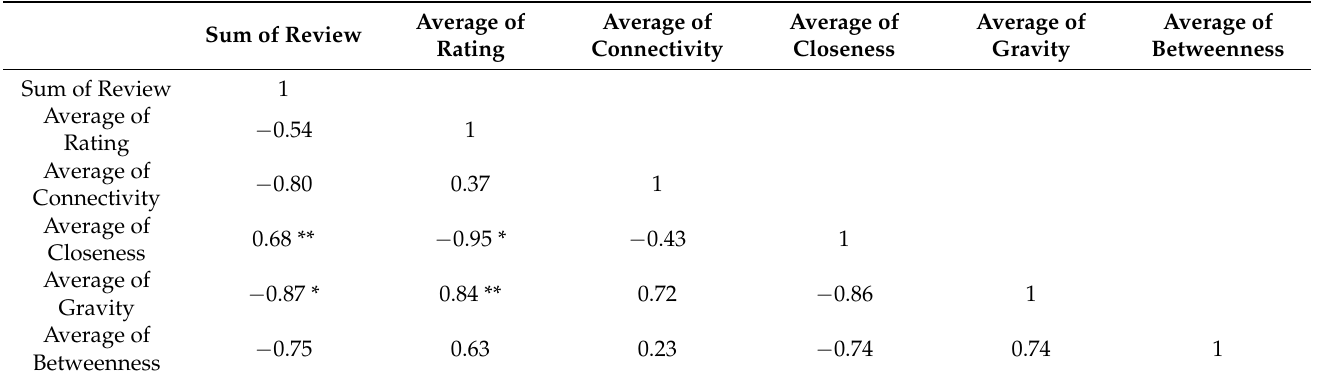
Table 9. Correlation of Digital Perception with Global Spatial Configuration.